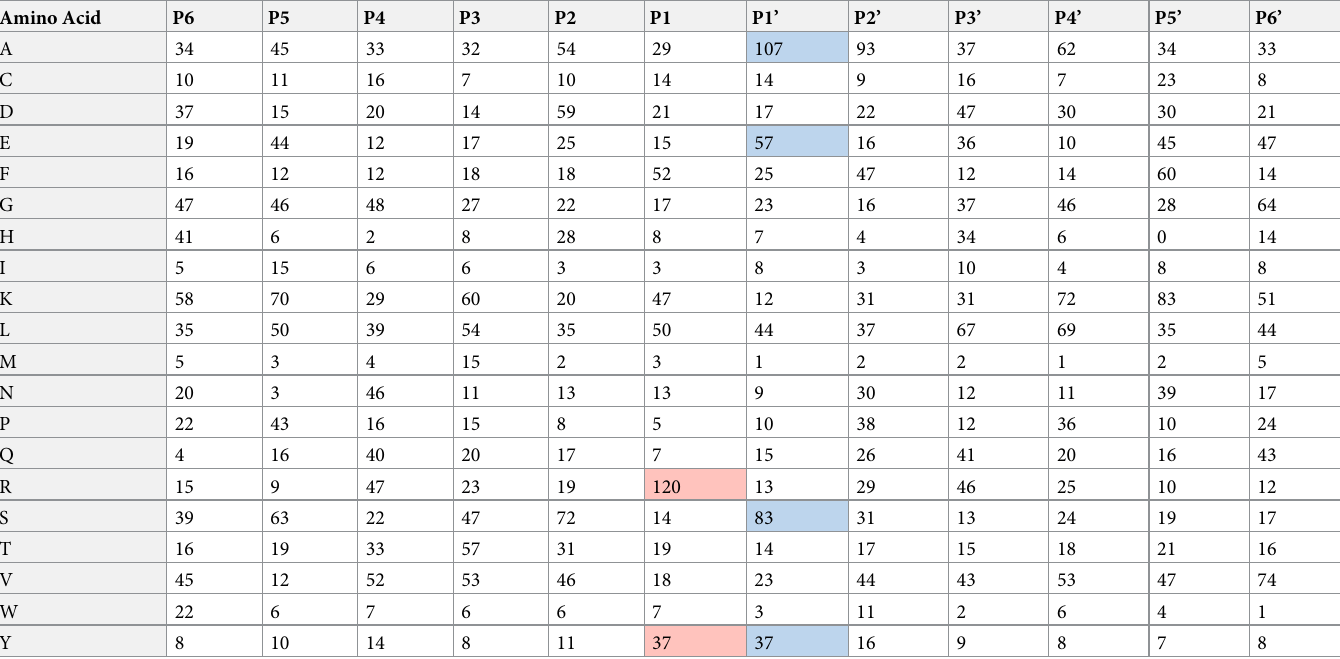
Table 1. Amino acid frequencies at N- and C-termini of